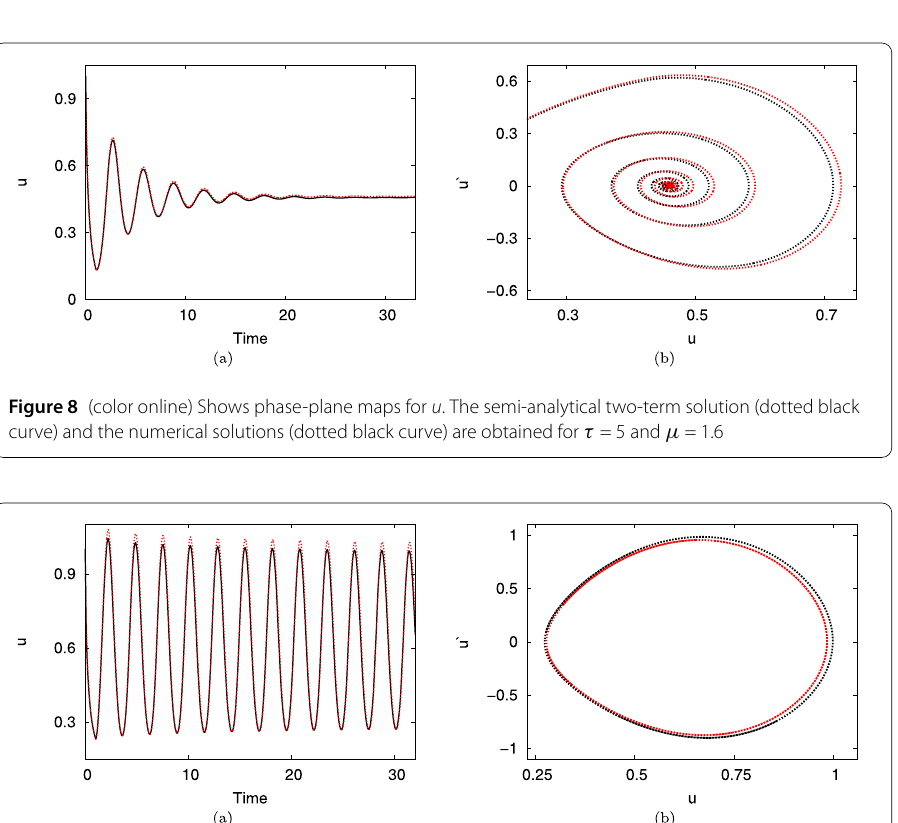
Figure 7 (color online) Bifurcation diagram of the growth rate μ versus population density u , with three different values of τ : τ = 10 (blue dashed curve), τ = 5 (red dotted curve), and τ = 3 (black solid curve). The two-term semi-analytical result is shown